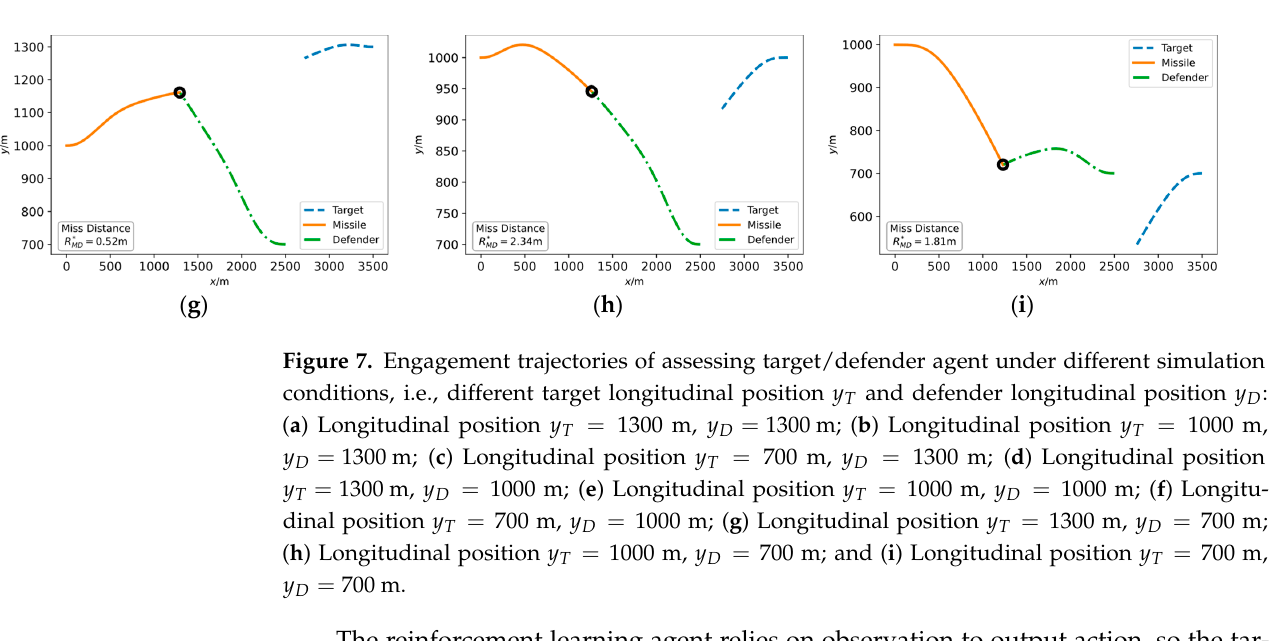
Figure 7. Engagement trajectories of assessing target/defender agent under different simulation con ‐ ditions, i.e., different target longitudinal position T y and defender longitudinal position